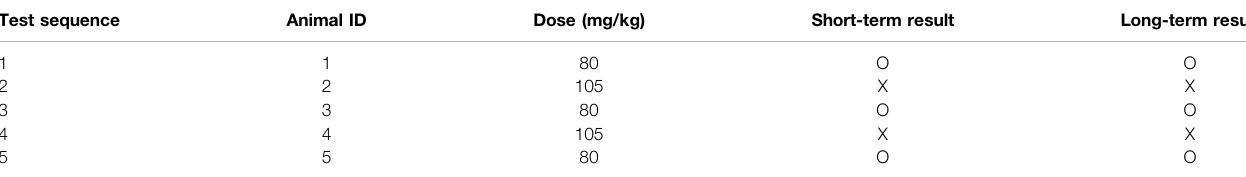
TABLE 1 | Experiment data of Cory acute toxicity. Test